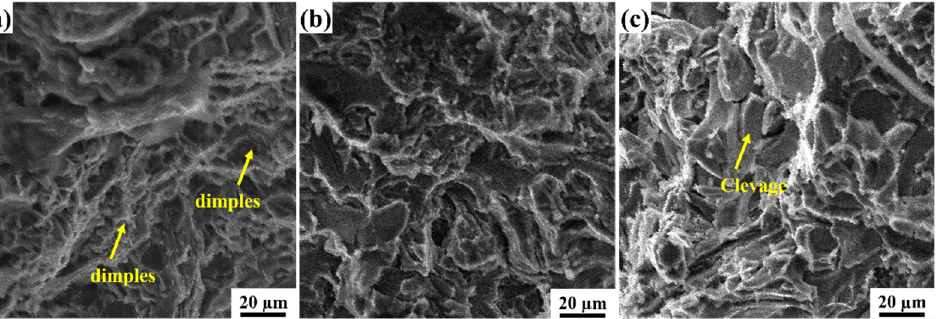
Figure 11. SEM fractographs of composites: ( a ) Al 6063–5 wt.% HEA, ( b ) LM25–5 wt.% HEA, and ( c ) LM25–10 wt.% HEA.